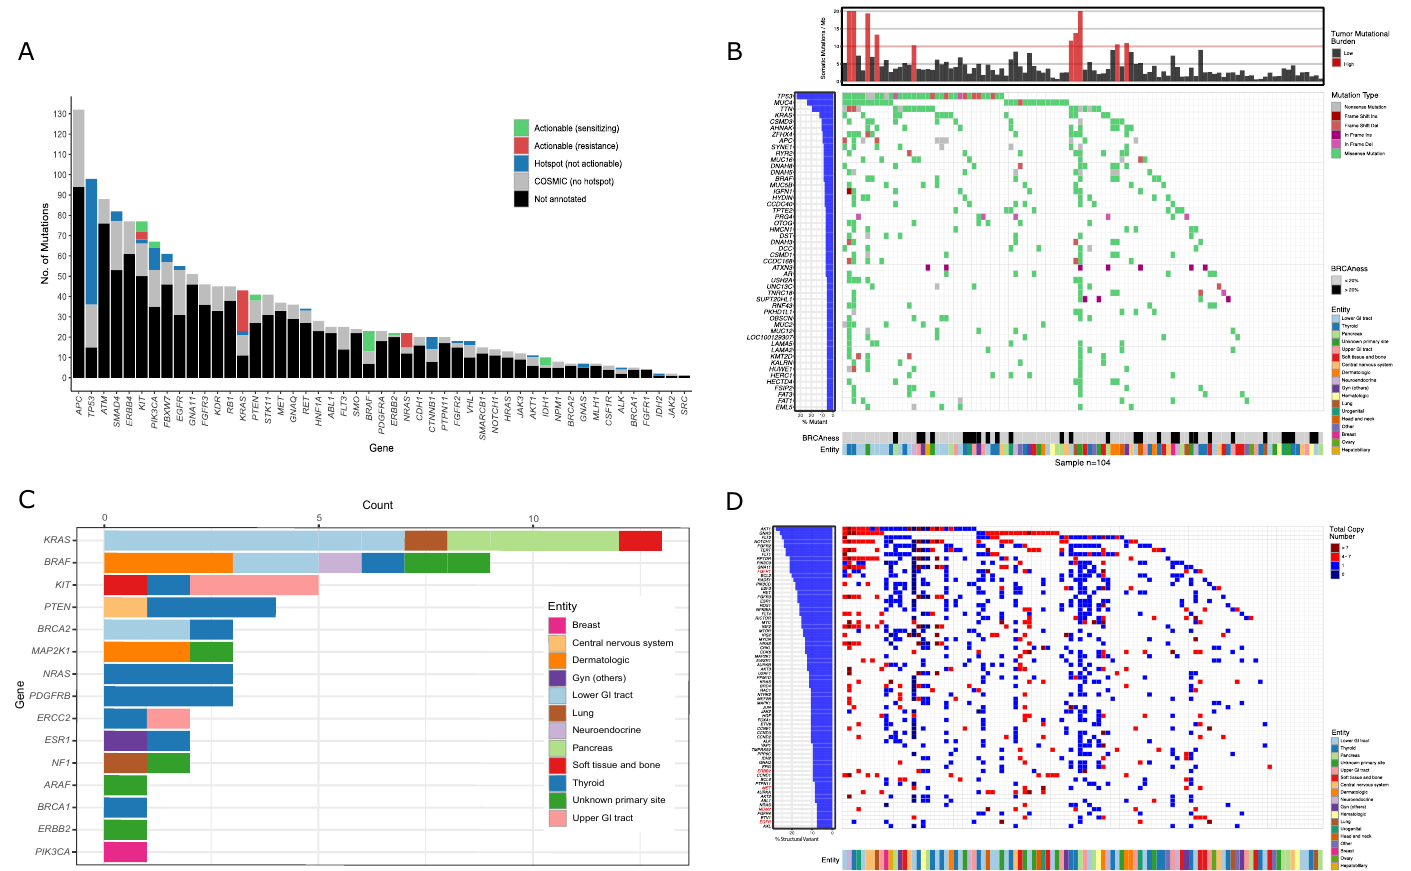
Figure 1. Results of sequencing: ( A ) The bar plot depicts the number of sequence variants detected in tumor DNA using the 48-gene panel for 221 patients. Colors indicate non-targetable COSMIC- (grey) and non-targetable hotspot mutations (blue). Actionable variants are shown in green (drug-sensitizing) and red (drug-resistance) based on the OncoKB classification. ( B ) The heatmap depicts the 50 most frequently mutated somatic genes of the 104 patients analyzed by whole-exome sequencing (WES). The colors indicate tumor entities, type of mutation, tumor mutational burden and BRCAness-score (= AC3 − signature). Only mutations with a variant allele frequency greater than 10% and a minor allele frequency less than 0.1% were considered. ( C ) The bar diagram depicts all mutations that were annotated as targetable by the OncoKB classification. The colors indicate tumor entities. ( D ) The heatmap depicts copy number variations of the most frequently affected oncogenes. The colors indicate tumor entities and the total copy number per oncogene. Gene copy number gains that were annotated as targetable by the OncoKB algorithm are depicted in